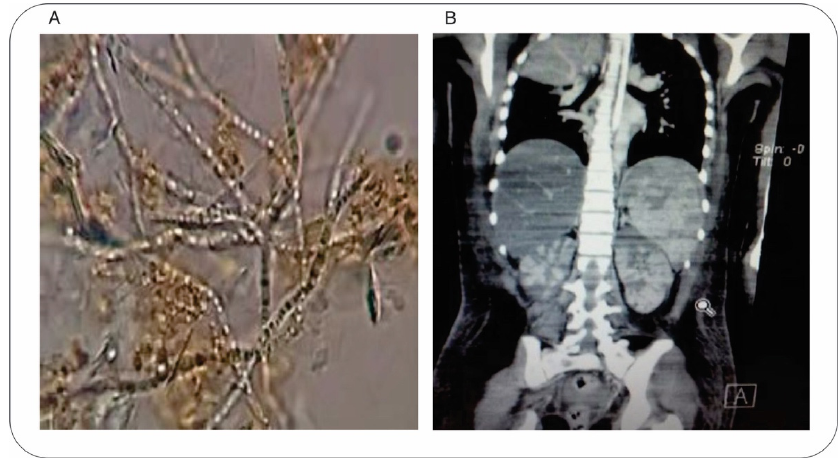
Figure 1. Identification of M. capitatus as the causal agent of IFI. ( A ) Microscopic evaluation (Zeiss Primo Star 415500 optical microscope, 40×) of a fresh sample of bile fluid with 20% of KOH, observing hyaline septate macrosiphoned hyphae structures. ( B ) Detection of M. capitatus invasion of internal organs with an abdominal CT scan. The coronal plane shows multiple injuries in the spleen and kidneys. Maximum-likelihood phylogenetic trees were constructed with nucleotide sequences from the ITS and 28S rRNA gene markers, utilizing MEGAX software, the bootstrap test of